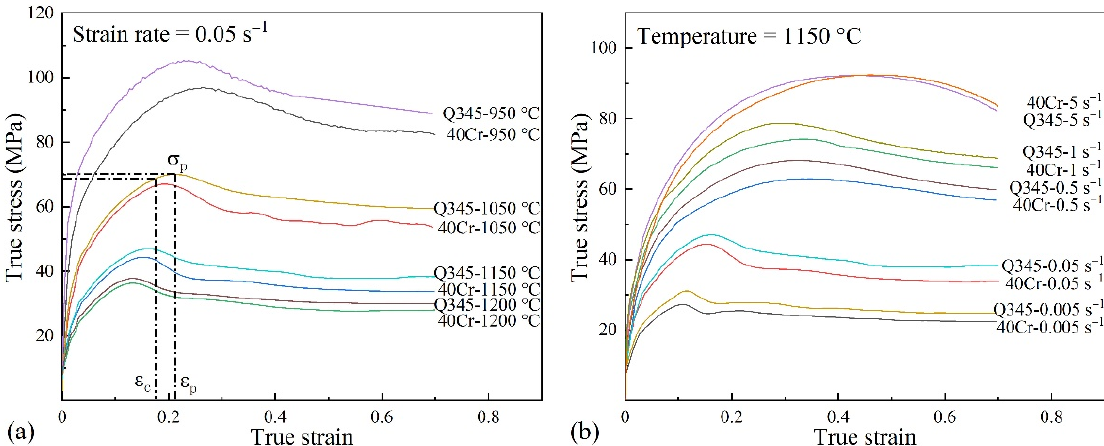
Figure 4. SEM images ( a ) and EDS spectra ( b ) of MnS in 40Cr/Q345B bimetallic blank.